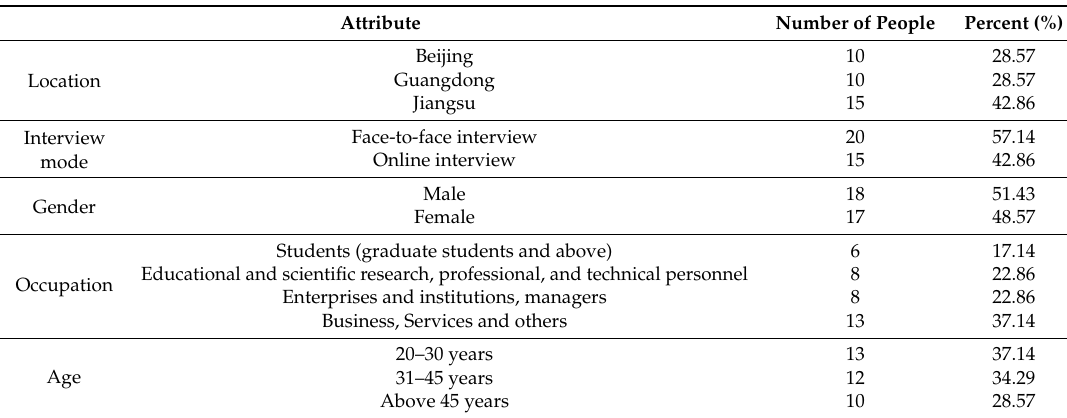
Table 2. Statistical information for the